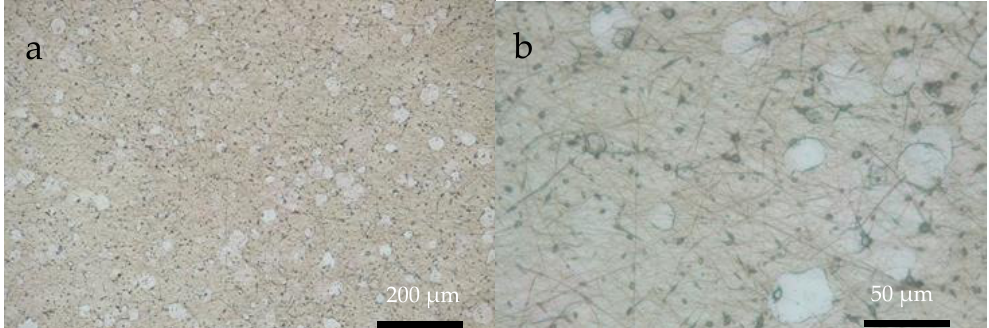
Figure 4. OM images of R-chitosan fibers supported on ITO substrate at ( a ) 10× and ( b ) 40× magnifications.